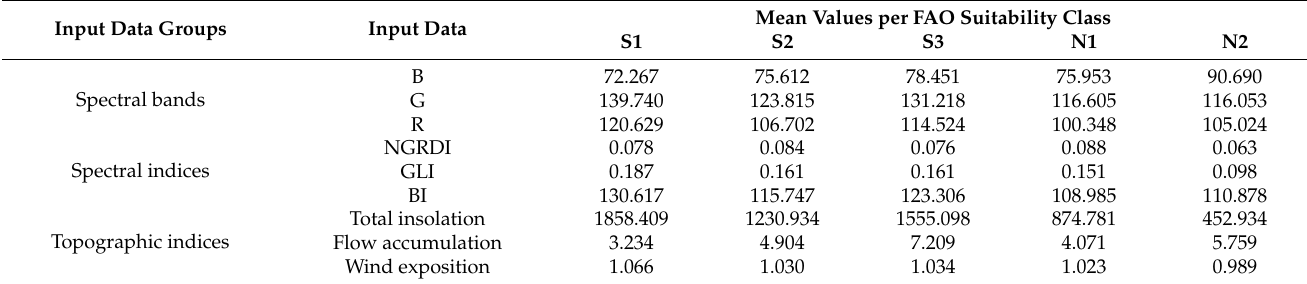
Table A1. Mean values of input data rasters per FAO suitability